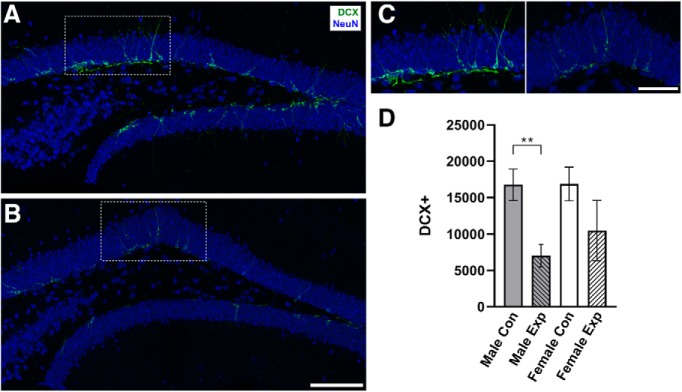
Measuring neurogenesis in the adult brain. A, B, Sample images of DCX expression in DG in sections from a male control animal (A) and a male experimental animal (B). C, Zoomed in views of DCX+ cells from A and B (left and right, respectively). D, Quantification of the number of DCX+ cells within the granule cell layer, expressed as the number of cells per cubic micrometer. The male experimental group (n = 13) showed a significant decrease relative to the male control group (n = 11; **p < 0.01). There was no significant difference between the female experimental group (n = 5) and the female control group (n = 6; p > 0.05). Error bars represent the SEM. Scale bars: B, 100 µm; C, 50 µm.